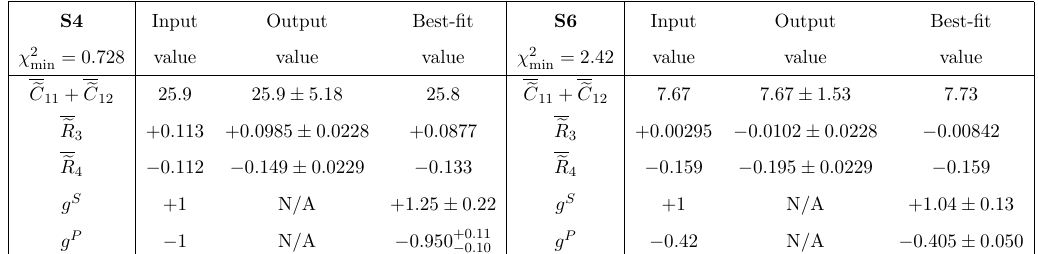
Table 3 . Summary of the results obtained with N evt = 10 4 and (cid:1)(cid:8) = (cid:25)= 9. The input values are the same as in table 2. The output values of e R 3 ; 4 have been obtained by (cid:12)tting to the normalized angular distributions in (cid:12)gure 2. For e C 11 + e C 12 , we simply assume 20 % error. Implementing (cid:31) 2 analysis gives the best-(cid:12)t values of g S and g P , see (cid:12)gures 3 and 4. Also shown are the best-(cid:12)t values for e C 11 + e C 12 and e R 3 ; 4 calculated using the best-(cid:12)t values of g S and g P .